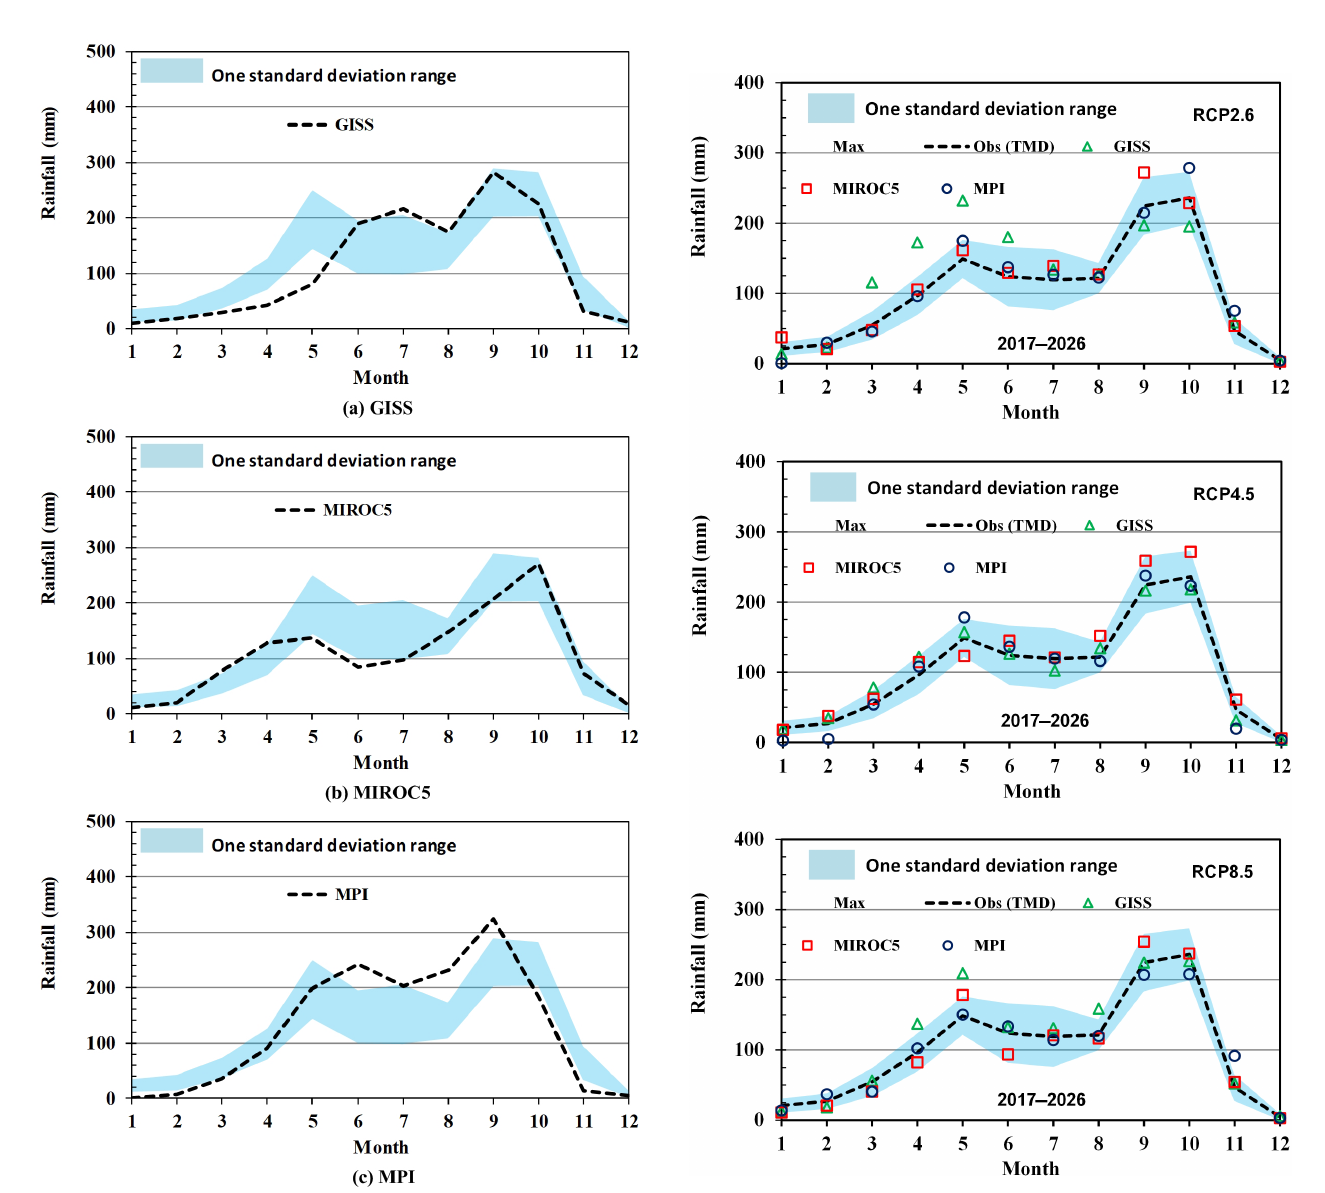
Figure 3. Comparison of Average Monthly Precipitation of the selected GCMs and observation (1991–2000) in Klong Yai River basin.